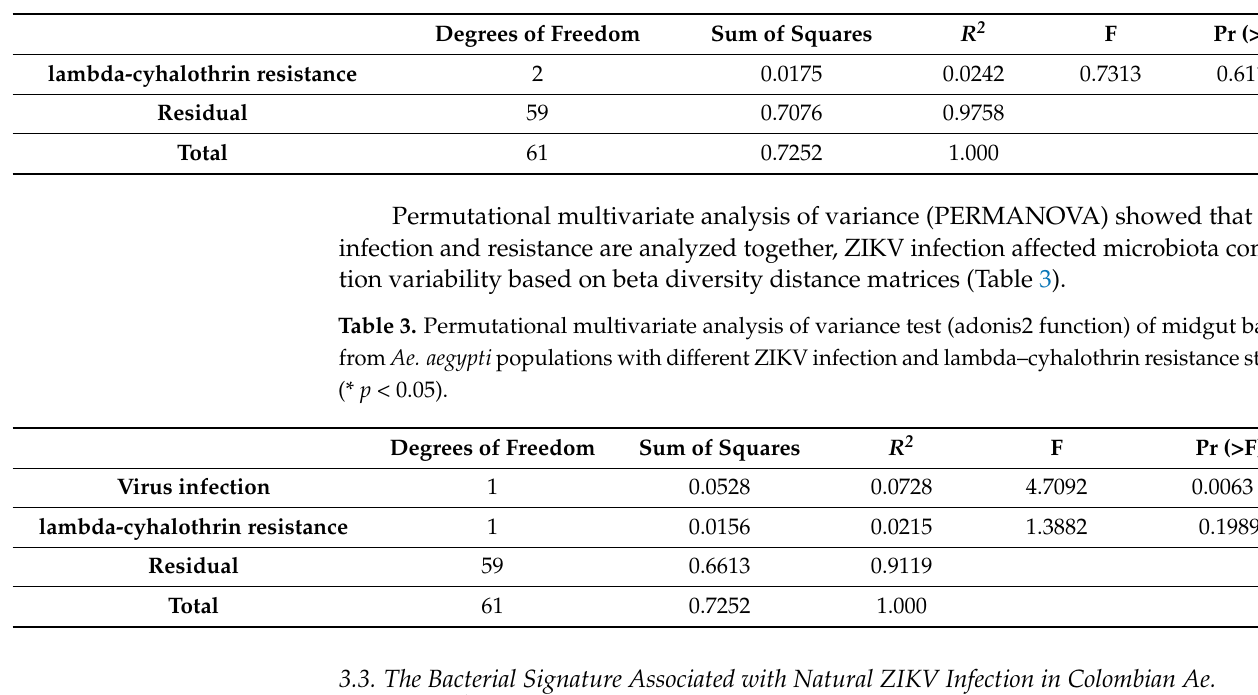
Table 2. Beta diversity analysis of Ae. aegypti midgut bacteria for lambda–cyhalothrin resistance status using the Adonis2 test.